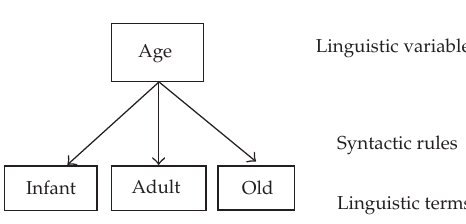
Figure 2: Three linguistic variables for age.